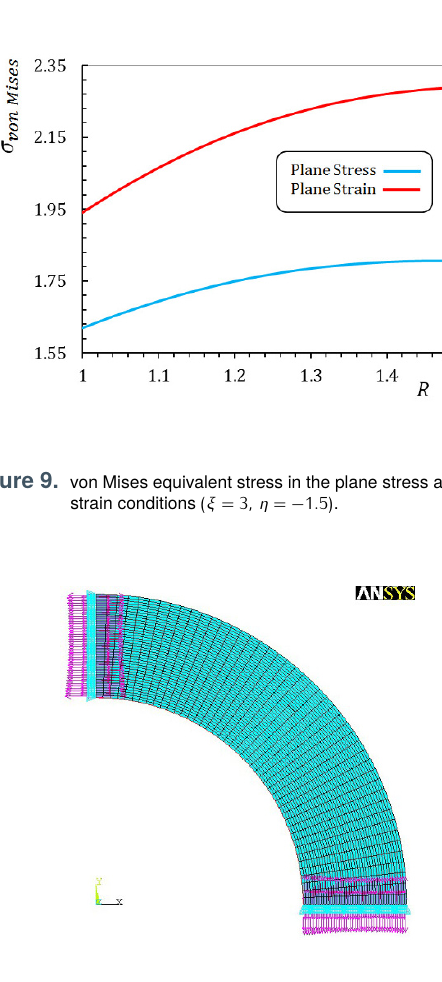
Figure 10. Finite elements mesh region.